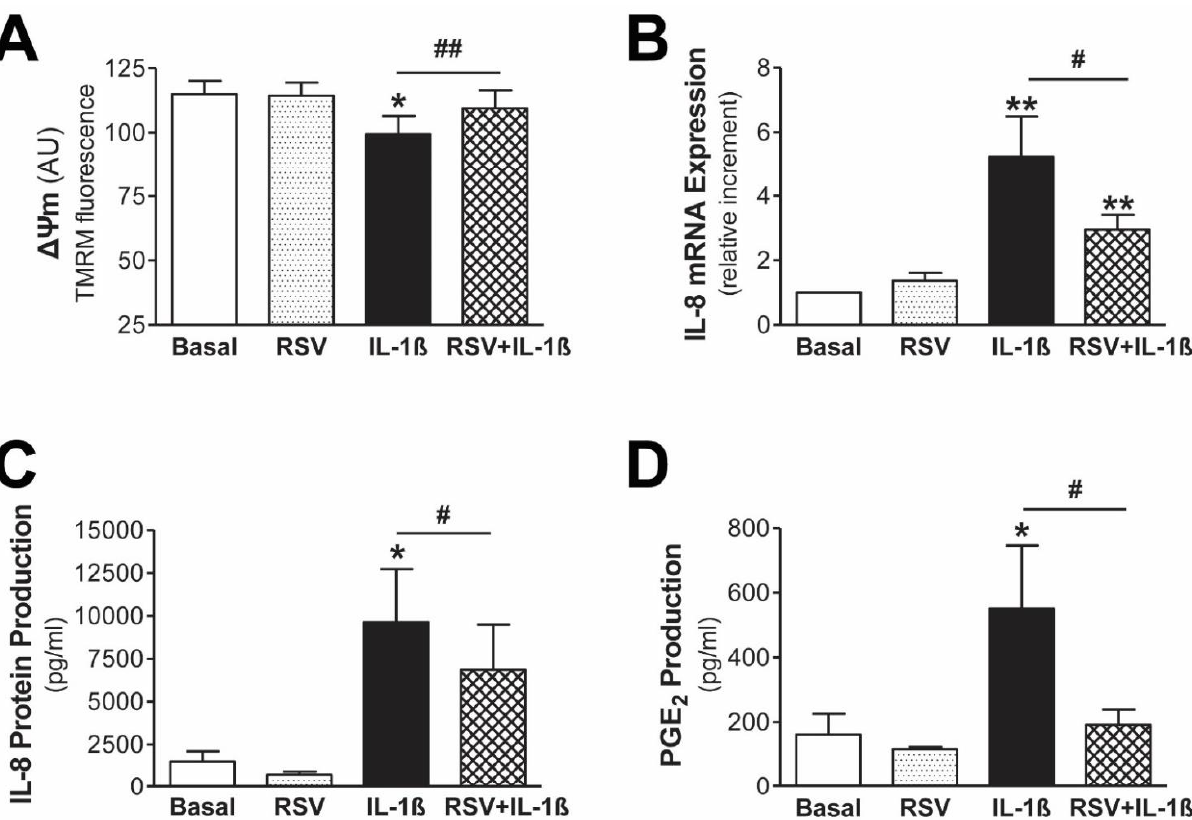
Figure 5. Resveratrol prevents mitochondrial dysfunction and the inflammatory response induced by IL-1 β in primary mesothelial cells from PD effluent. Mesothelial cells with an epithelial phenotype were pretreated with resveratrol (RSV; 5 µ M) for 30 min before treatment with IL-1 β (1 ng/mL). ( A ) Mitochondrial membrane potential was measured by flow cytometry after 12 h of stimulation with IL-1 β . Fluorescence quantification for TMRM (n = 7) is expressed as the mean ± SEM of fluorescence intensity in arbitrary units (AU). ( B ) IL-8 mRNA expression after 6 h of stimulation with IL-1 β is expressed as the mean ± SEM fold change vs. basal condition (n = 9). ( C ) IL-8 protein (n = 6) and ( D ) PGE2 production (n = 6) were measured by ELISA after 6 h of stimulation with IL-1 β . Data are expressed as mean ± SEM pg/mL. * p ≤ 0.05 and ** p ≤ 0.01 vs. basal, and # p ≤ 0.05 and ## p ≤ 0.01.